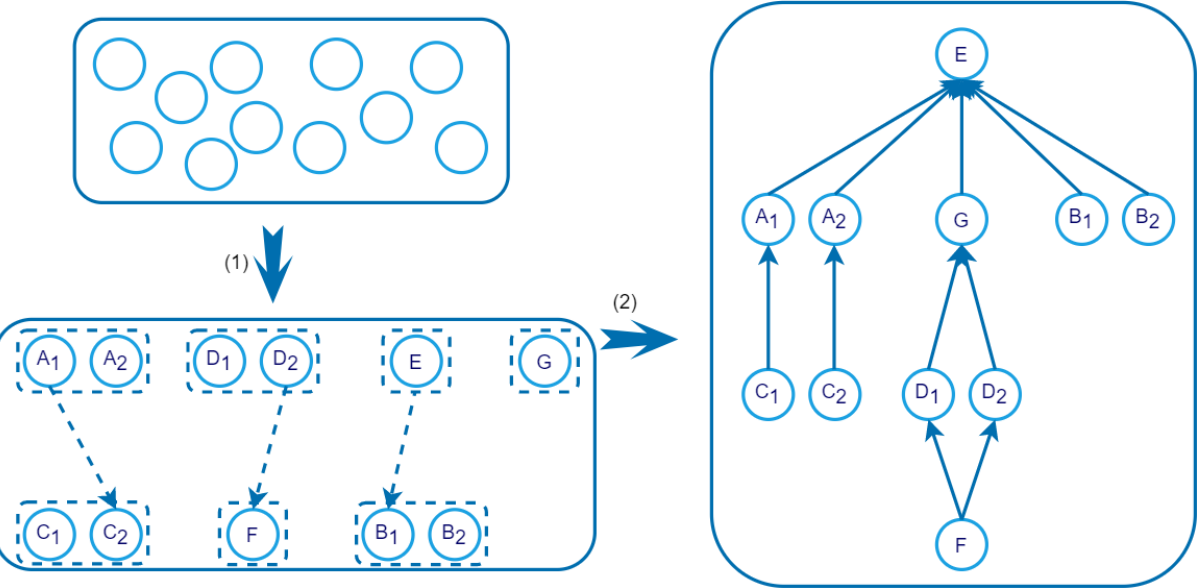
Figure 2. The use of lexical granularity to obtain the relative positions of terms. (1) Parallel concept sets (PCS) and PCS thread detection; 7 PCS nodes and 4 PCS threads were detected in this example. PCS: represented by dashed rectangles; Concept names: represented by circles; Substring relations: represented by dashed arrows. (2) Relation prediction. is-a or part-of relations predicted by the classification model: represented by solid